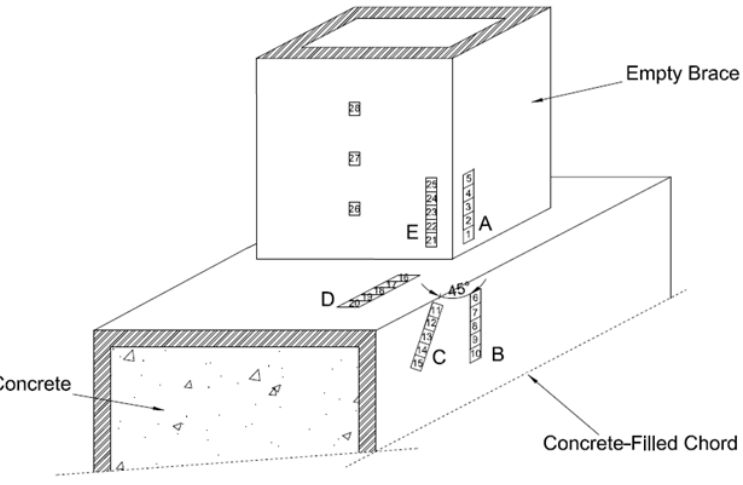
Figure 1. Locations of strain gauges.